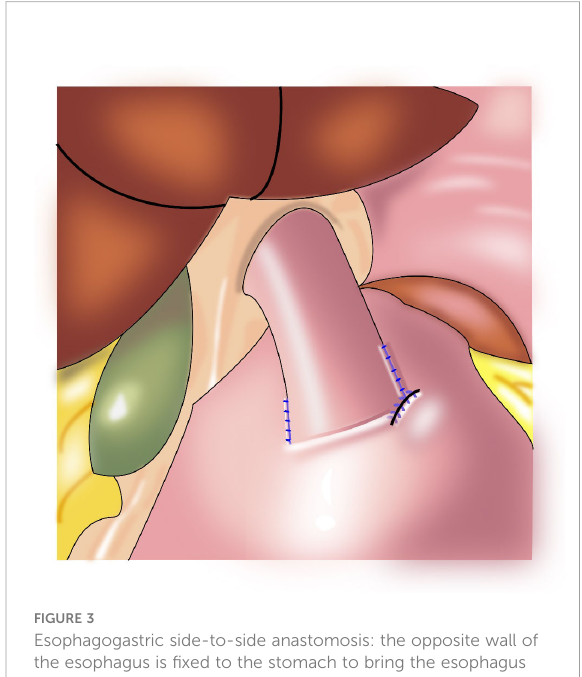
FIGURE 3 Esophagogastric side-to-side anastomosis: the opposite wall of the esophagus is fi xed to the stomach to bring the esophagus close to the stomach